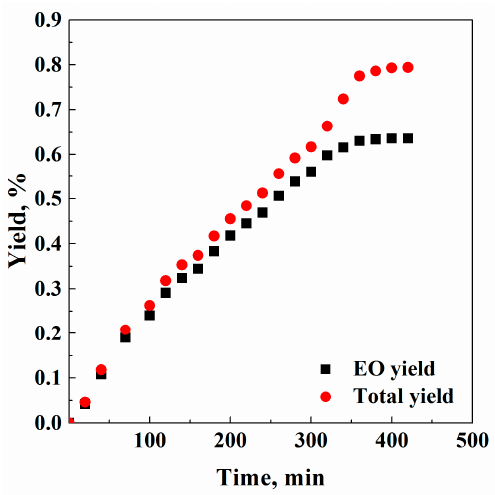
Figure 1. Representation of supercritical fluid extraction (SFE) total yield and essential oil (EO) yield versus time: 250 bar and 40 °C.